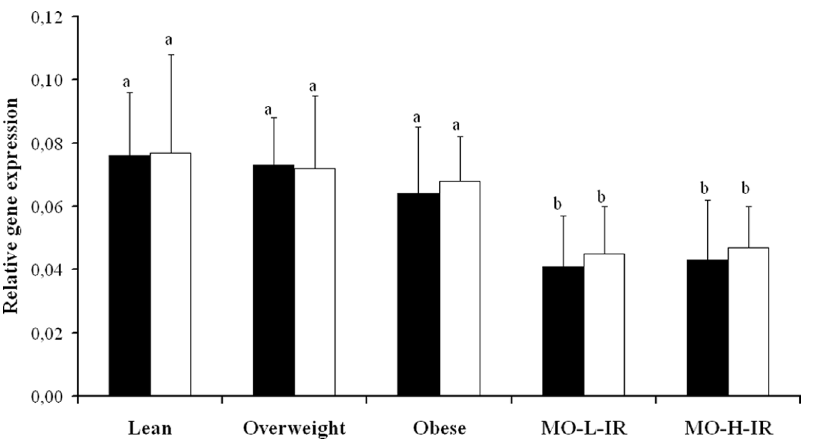
Figure 1. Munc18c gene expression in adipose tissue from the different groups of patients. The lean, overweight and obese persons had a significantly greater Munc18c gene expression in subcutaneous (SAT Munc18c) ( % ) and visceral (VAT Munc18c) adipose tissue ( & ) than the morbidly obese cohort. MO-L-IR: morbidly obese persons with low insulin resistance. MO-H-IR: morbidly obese persons with high insulin resistance. The results are given as the mean 6 standard deviation. Different letters indicate significant differences between the means of the different groups of subjects (P , 0.05).